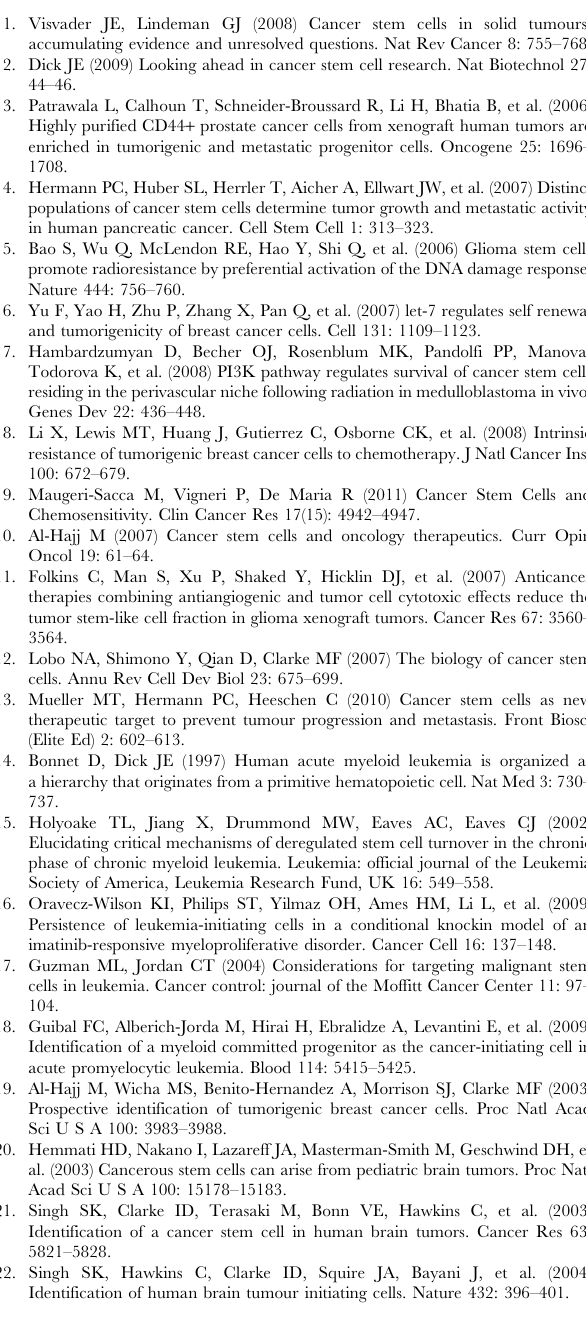
used to estimate the frequency of tumorigenic cells. The frequency of tumorigenic cells was compared between CSC + or CSC 2 cells from the same tumor cell line, * P , 0.5, ** P , 0.01. Table S2 CSC + and CSC 2 cells are capable of generating both progenies. In in vitro study, DsRed-labeled CSC + and EGFP- labeled CSC 2 cells originating from the same tumor cell lines were mixed according to their original ratios and co-cultured in serum- containing medium for 20 passages; In in vivo study, DsRed-labeled CSC + and EGFP-labeled CSC 2 cells originating from the same tumor cell lines were mixed according to their original ratios and co-transplanteded into the animals to generate xenografts (see